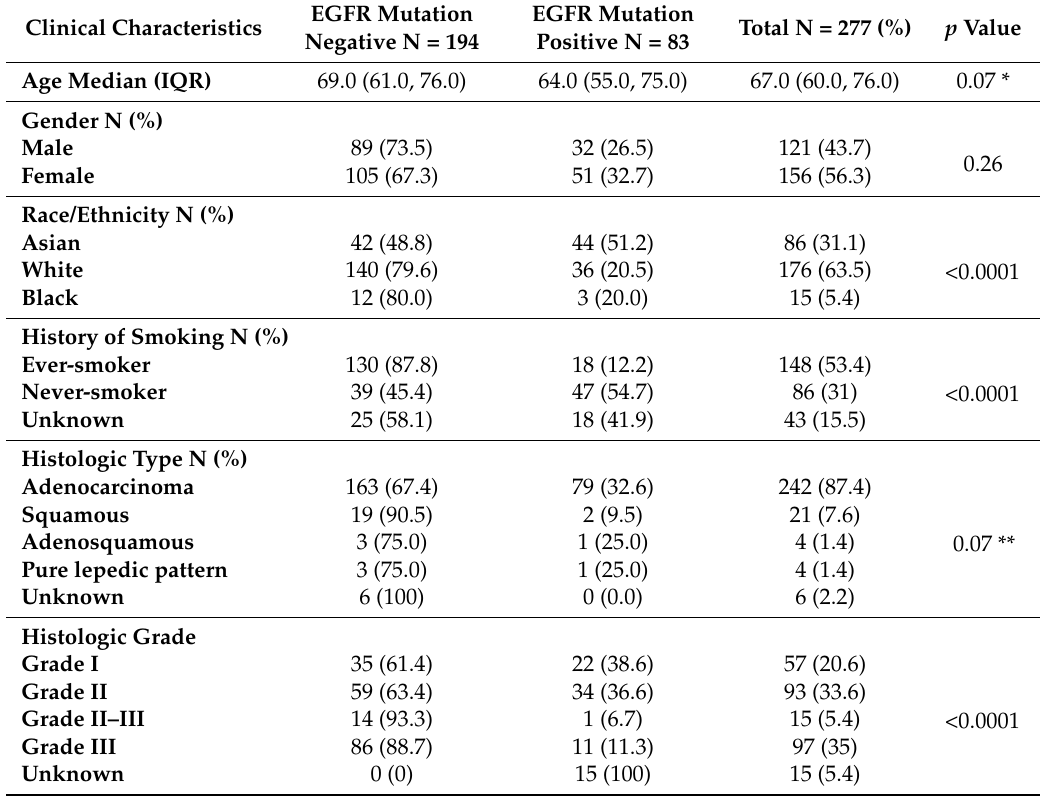
Table 1. Incidence of epidermal growth factor receptor (EGFR) mutation by clinical characteristics. Clinical